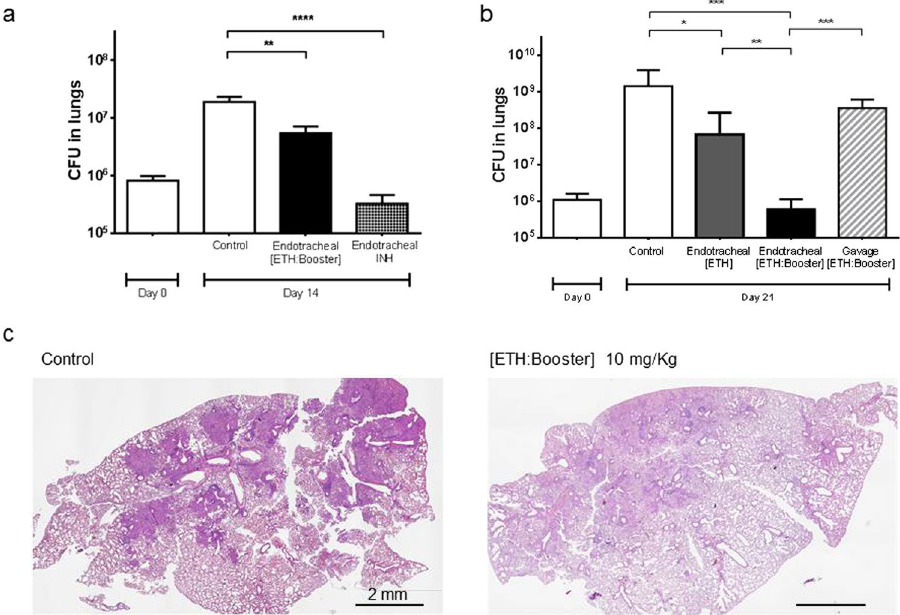
Figure 6. Effect of [ETH:Booster] loaded pCD NPs in a mouse model of M . tuberculosis infection. Intranasal infection was performed with M . tuberculosis H37Rv. ( a ) After 7 days mice were aerosolized endotracheally either with isoniazid (INH, 25 mg/Kg) as positive control or drug loaded nanoparticles (10 mg/Kg) three times during one week. At day 14 post-infection, mice were euthanized and CFU in the lungs were determined. Control: non-treated M . tuberculosis infected mice. Data are mean values ± standard deviation of